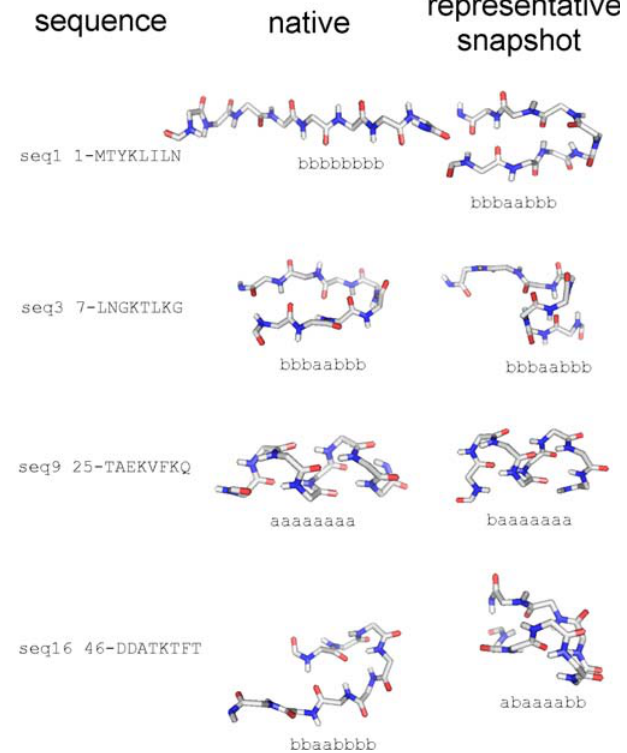
Figure 1. Representative Snapshots of Various Peptides from Protein G The representative snapshot is the snapshot in the ground mesostring with the lowest energy. The ground mesostring of seq1 and seq3 are classed as reverse-turns, and the ground mesostring of seq9 and seq16 are classed as helical-turns. DOI: